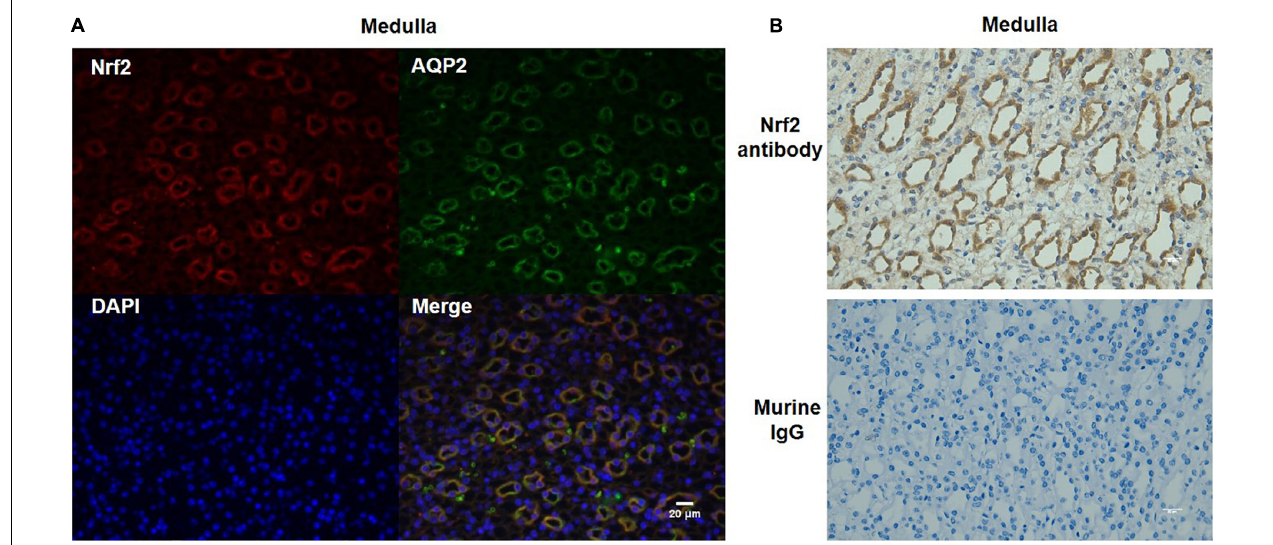
FIGURE 3 | Co-localization of Nrf2 and AQP2 in normal kidneys. (A) Immunofluorescent co-labeling with anti-Nrf2 and anti-AQP2 antibody in normal kidneys. Nrf2 is shown as red color. AQP2 is shown as green color. DAPI staining is shown as blue color. Magnification: 400 × . Scale bar: 20 µ m. (B) Analysis of Nrf2 antibody specificity for immunostaining by replacing Nrf2 antibody with murine IgG. The images shown are representative of five normal animals.